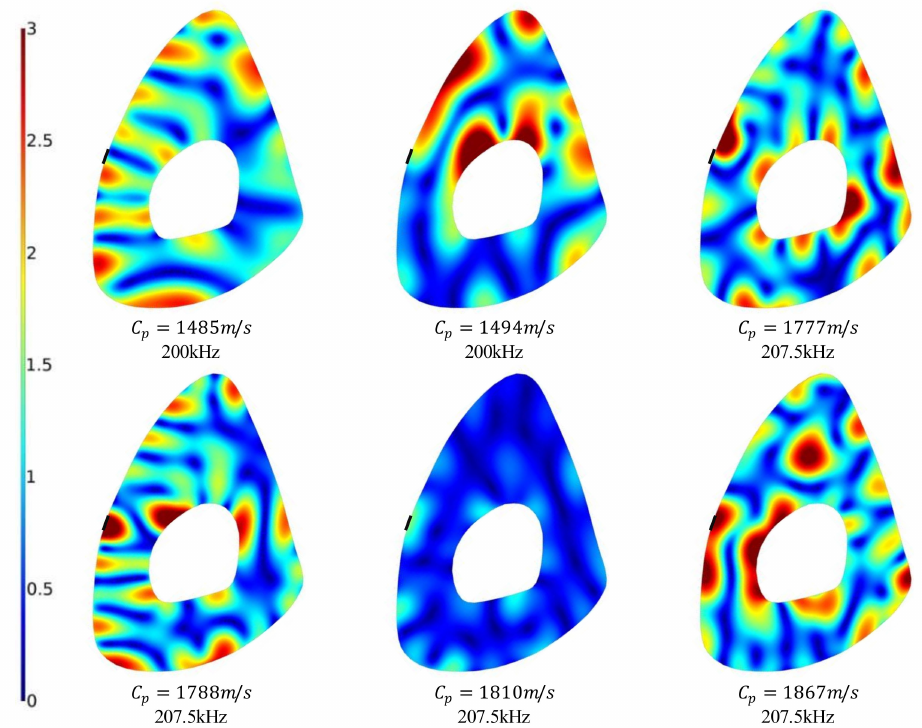
Figure 7. 2D wave structures from SAFE analysis for the eigenvalues corresponding to the dispersion curve region for the extracted phase velocities are shown. The wave structures are expressed as displacement magnitude distribution corresponding to the in-plane displacement components v and w √ v 2 + w 2 combined as